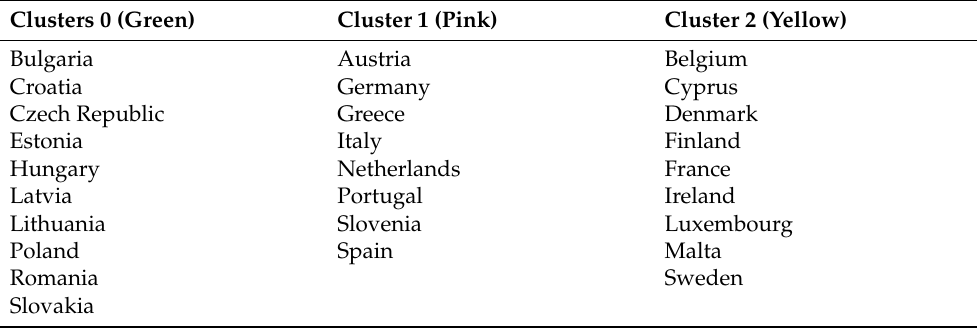
Table 4. Division of countries into clusters in terms of health, K-means clustering algorithm method. Clusters 0 (Green) Cluster 1 (Pink) Cluster 2